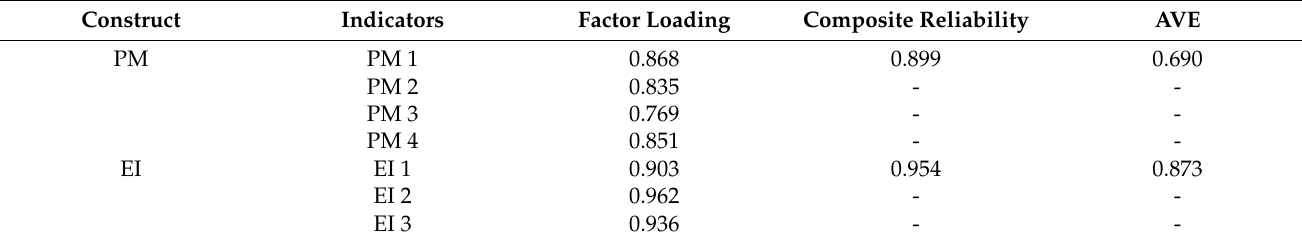
Table 3. Reliability and AVE of the measurement model (outer model).